Question: Name the type of graph shown.
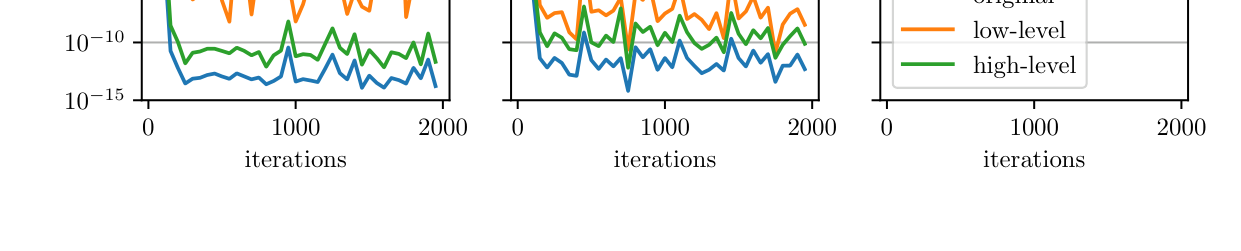
Answer: line